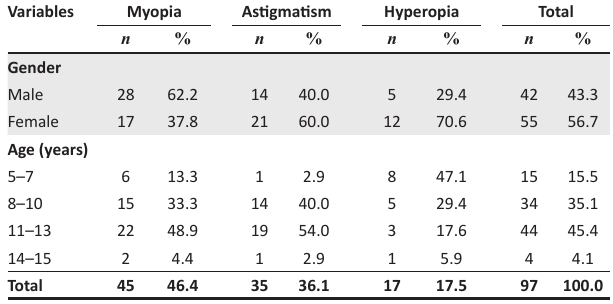
TABLE 2: Age and gender distribution of refractive errors.